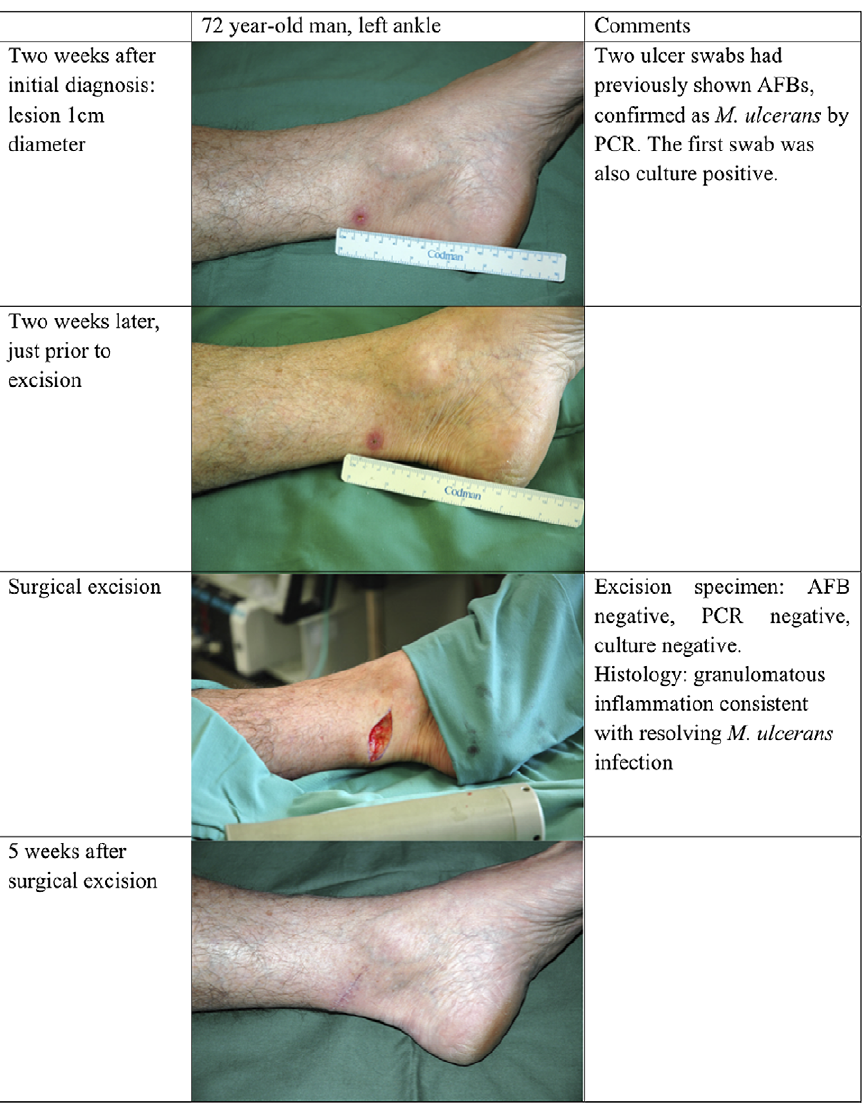
Figure 1. Clinical appearance and laboratory characteristics.